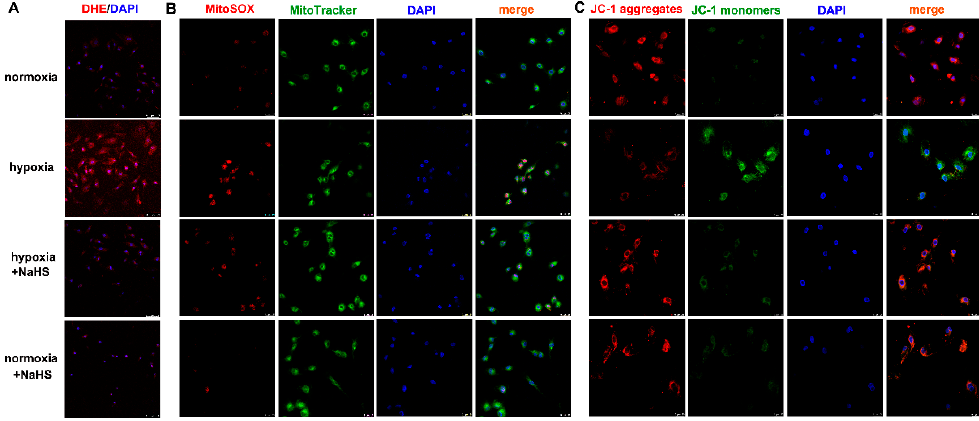
Figure 5. NaHS alleviated the oxidative stress and improved the mitochondrial membrane potential in cardiac fibroblasts with hypoxia. After pre-administration with NaHS (50 μ M) for 4 h, neonatal rat cardiac fibroblasts were subjected to normoxia (containing 5% CO 2 and 95% O 2 ) or hypoxia (containing 5% CO 2 and 1% O 2 ) for 4 h. ( A ) The superoxide anion level was evaluated by DHE (red) staining. The nuclei were stained with DAPI (blue). Bar = 75 μ m. ( B ) Mitochondrial ROS production was detected by MitoSOX (red) staining, and mitochondria were localized by MitoTracker (green) staining. The nuclei were stained with DAPI (blue). Bar = 25 μ m. ( C ) The mitochondrial membrane potential was assessed by JC-1 staining. The nuclei were stained with DAPI (blue). Bar = 25 μ m.